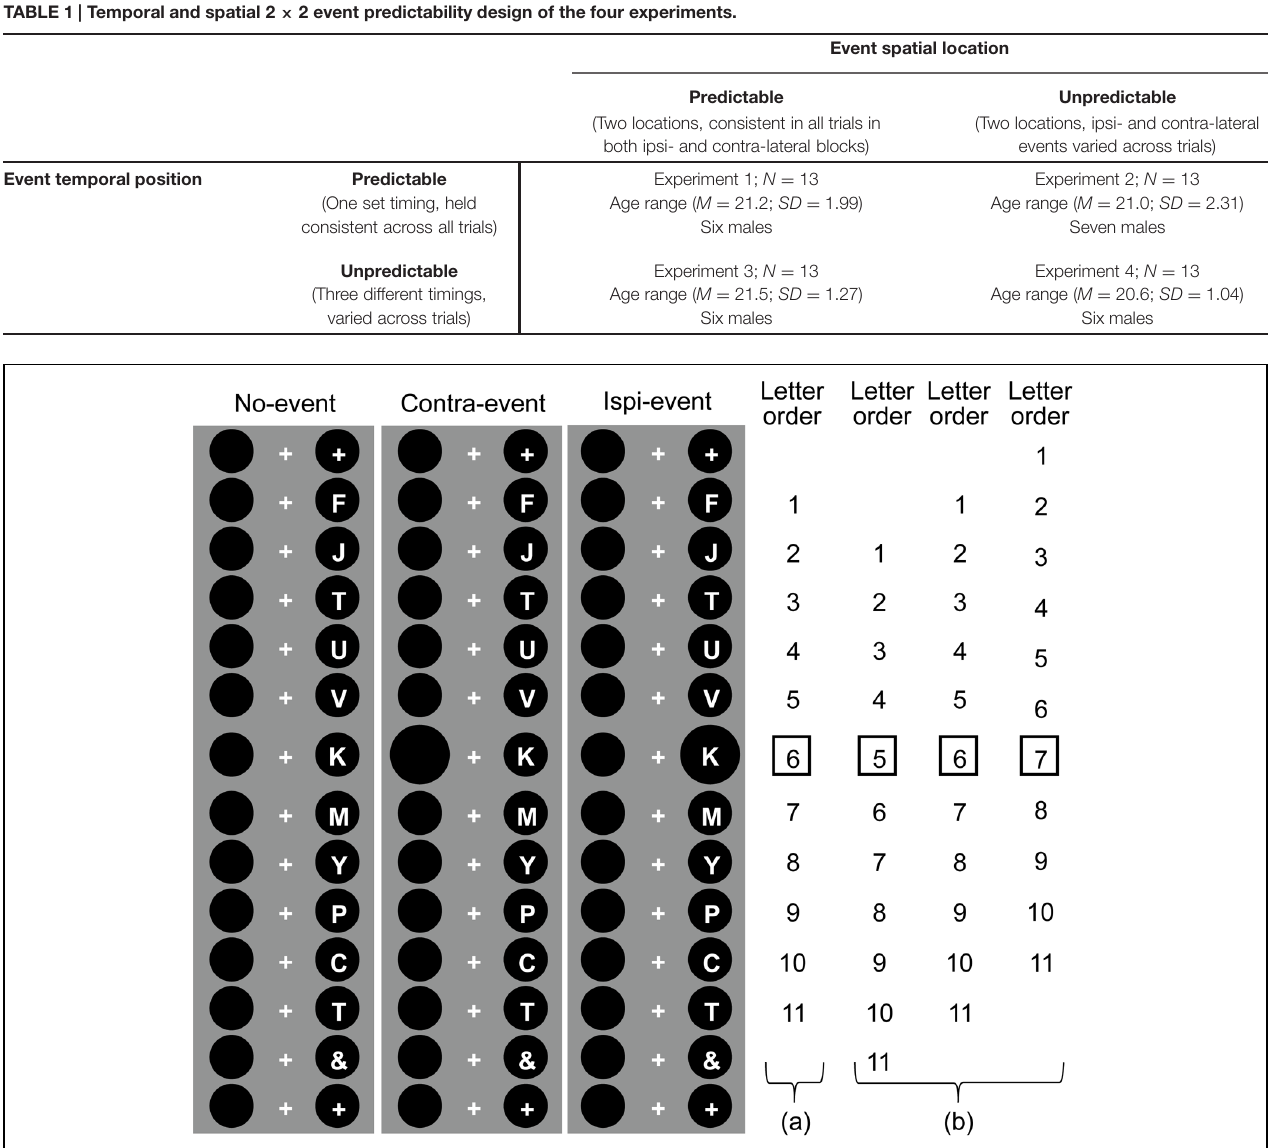
FIGURE 1 | Time course of the stimulus sequence and event occurrence (see Ohyama and Watanabe, 2010 for similar task illustration in a different design). The vertical line in this figure represents the time course of the visual sequence. The event was a disk that enlarged simultaneously with the appearance of one letter in the serial sequence. The disk enlargement event occurred at the disk with the letter (ipsi-event) or at the disk on the other side (contra-event). In the spatially predictable condition, the ipsi- and no-event trials were shuffled in the ipsi-lateral event block, and the contra-vent and no-event trials were separately examined in the contra-lateral block. Thus, the event location was kept consistent in each block. In the spatially unpredictable condition, the ipsi-, contra-, and no-event trials were shuffled in a block; therefore, the location that the event occurred at was randomized. (a) In the temporally predictable condition, the event always occurred with the 6th letter in the sequence across all trials. (b) In the temporally unpredictable condition, the event occurred with the 5, 6, or 7th letter in the sequence, i.e., it varied across